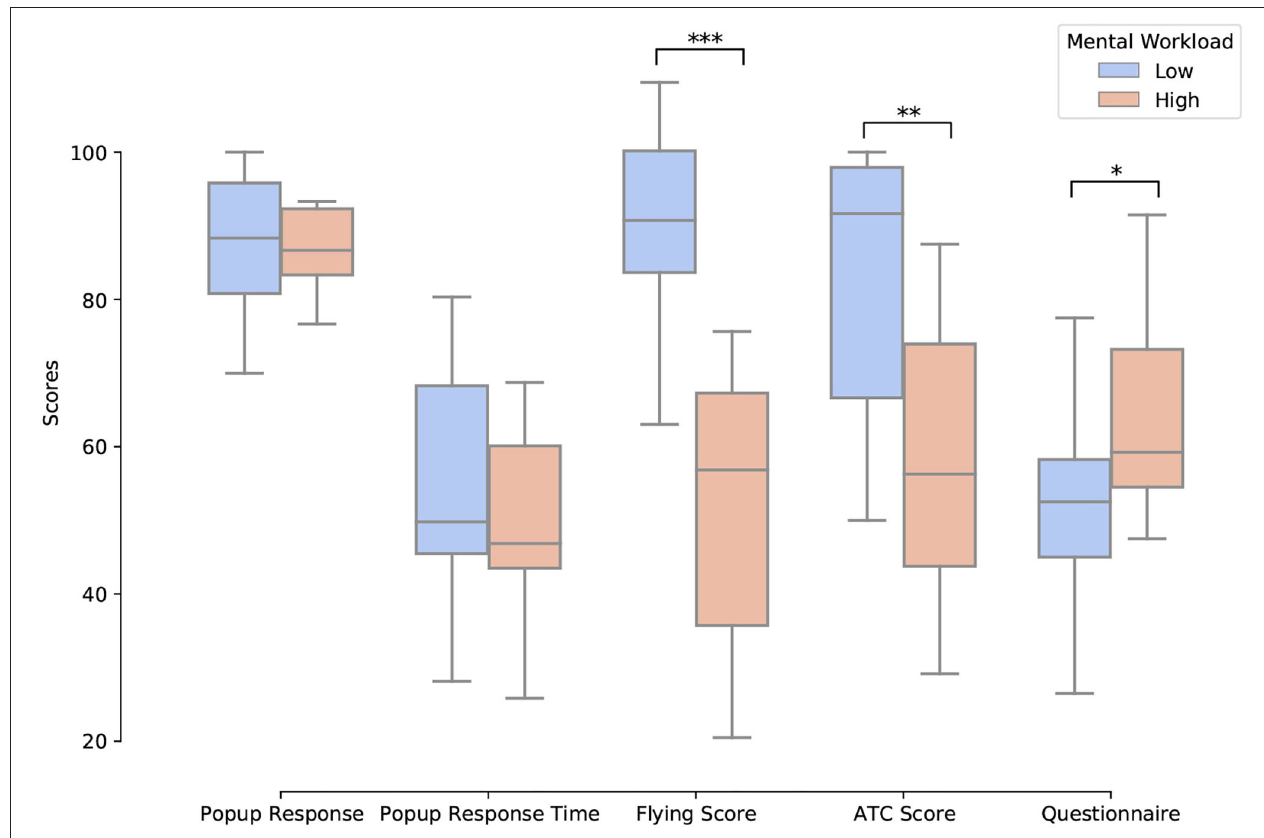
FIGURE 7 | Illustration of the statistical results for the subjective and behavioral metrics for 14 participants using Paired t -test. *** p < 0.001, ** p < 0.01, and * p < 0.05. Pop-up response time is multiplied by 10 for visualization